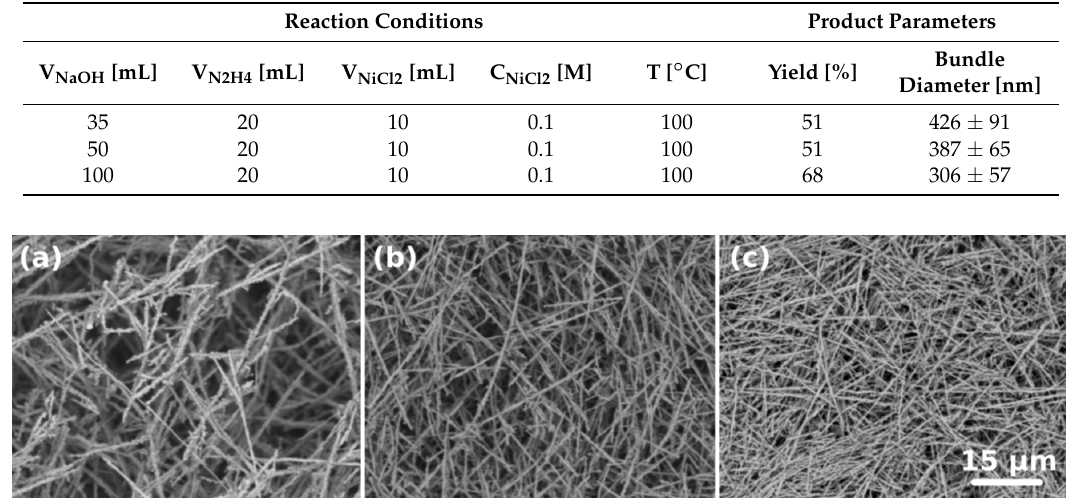
Figure 2. Micrographs of the NiNWs formed after the addition of a selected volume of 0.1 M NaOH: ( a ) 35 mL, ( b ) 50 mL, and ( c ) 100 mL.